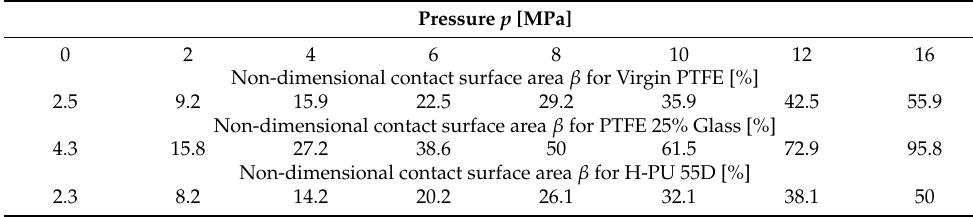
Table 2. Values of the non-dimensional contact surface area β .